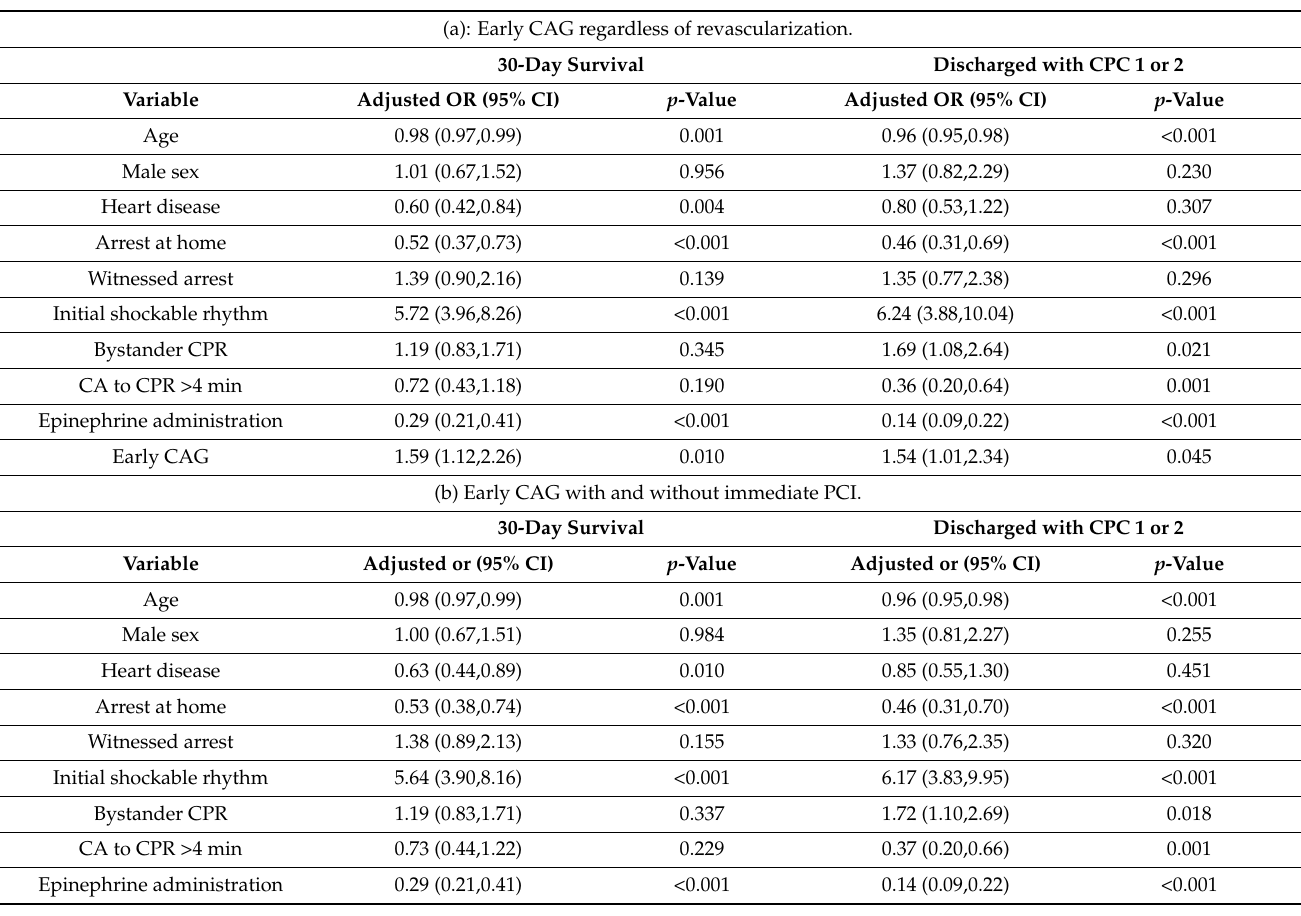
Table 3. Predictors of outcomes by logistic regression.